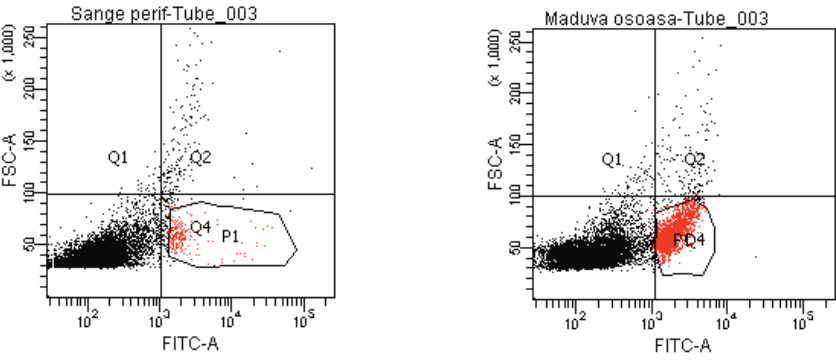
Fig. 4. The results of the FACS analysis for peripheral blood and bone